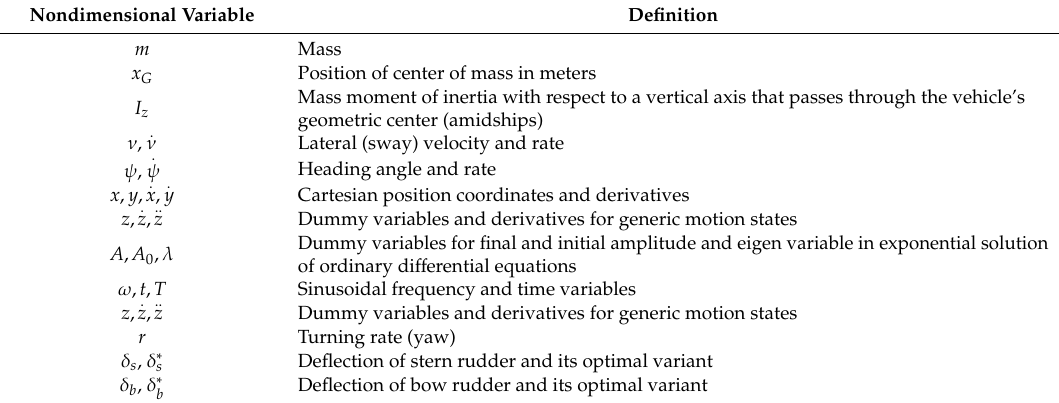
Table 1. Definitions of variables in this part of the manuscript (while a consolidated list is provided in the Appendix).